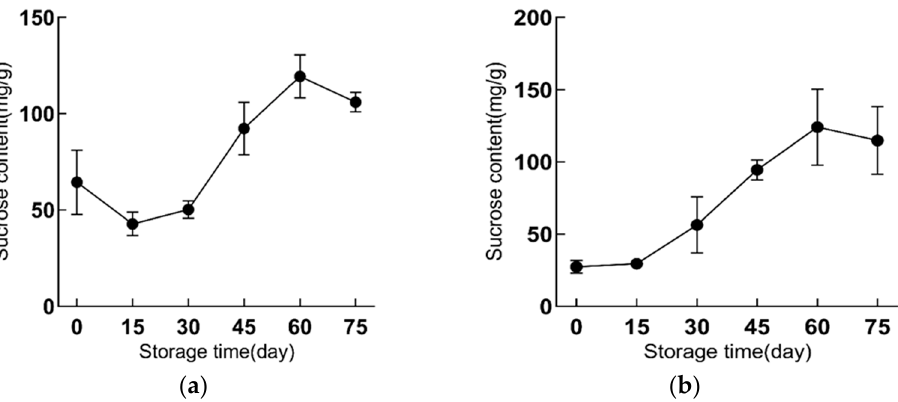
Figure 3. The changes of sucrose of functional lily during cold storage. ( a ) represents ‘Fly Shaohua’, ( b ) represents ‘Fly Tiancheng’. Sucrose content has three biological repeats.